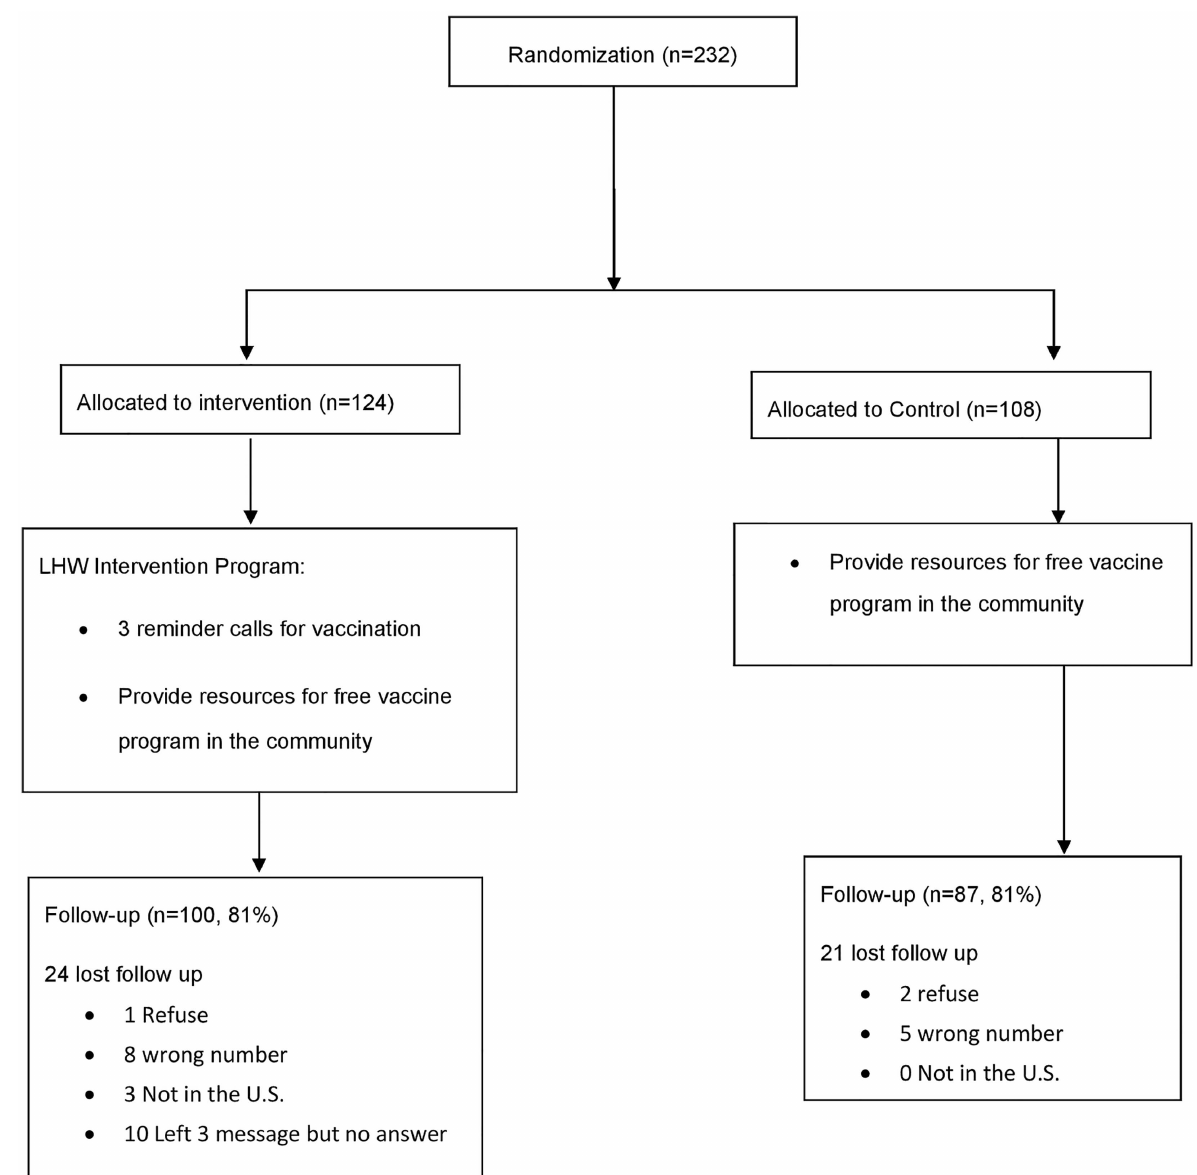
Fig 1. Flow of participants throughrandomized